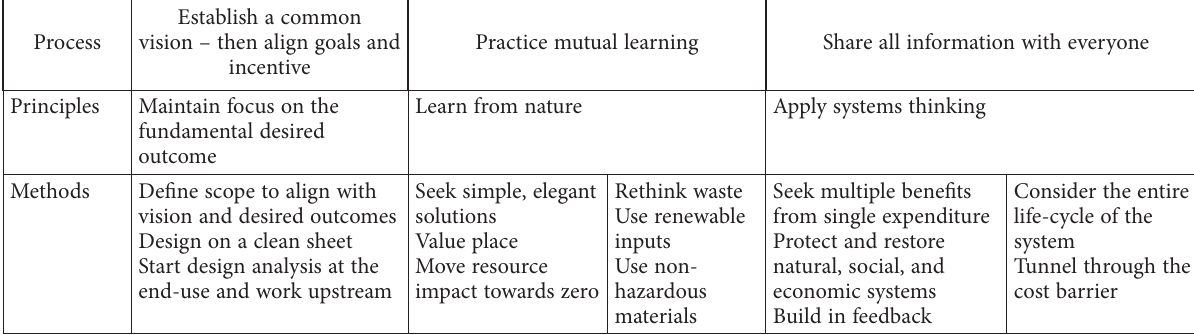
Table 1. Whole systems design framework (adapted from Blizzard and Klotz, 2012)